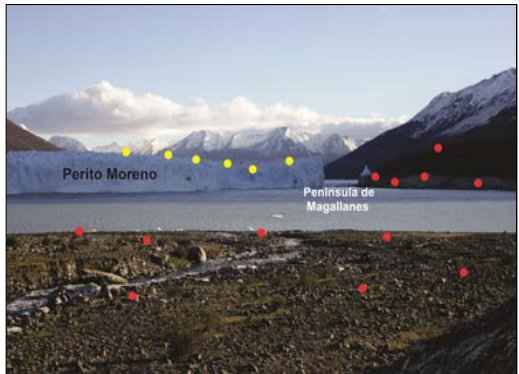
Figure 3. GCPs (red color) and check points (yellow color) distributed along the image.